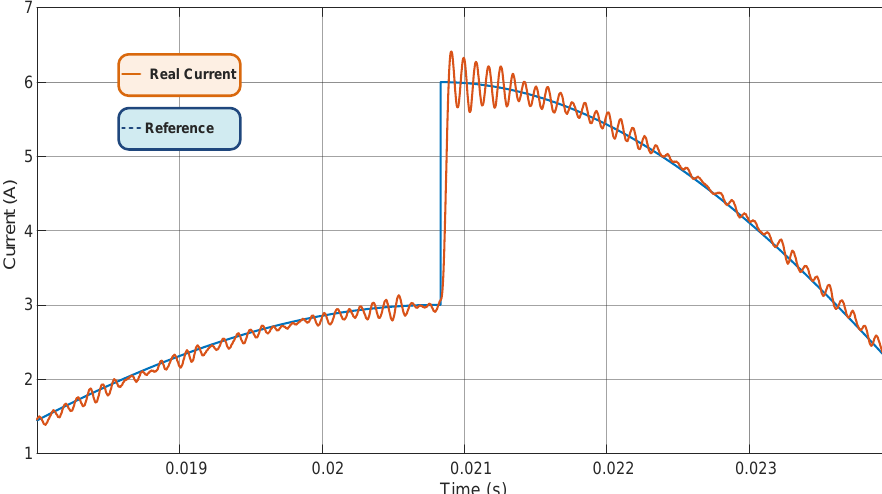
Figure 16. Step response tracking with SMC plus P + R.